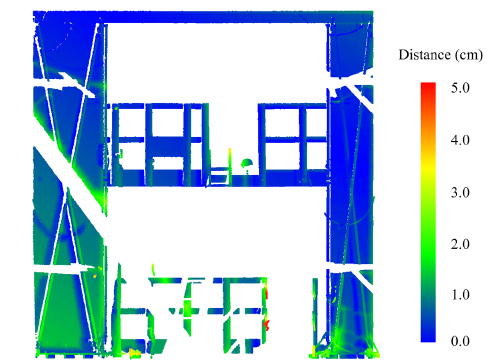
Figure 16: Point to point distance of the coarse registration